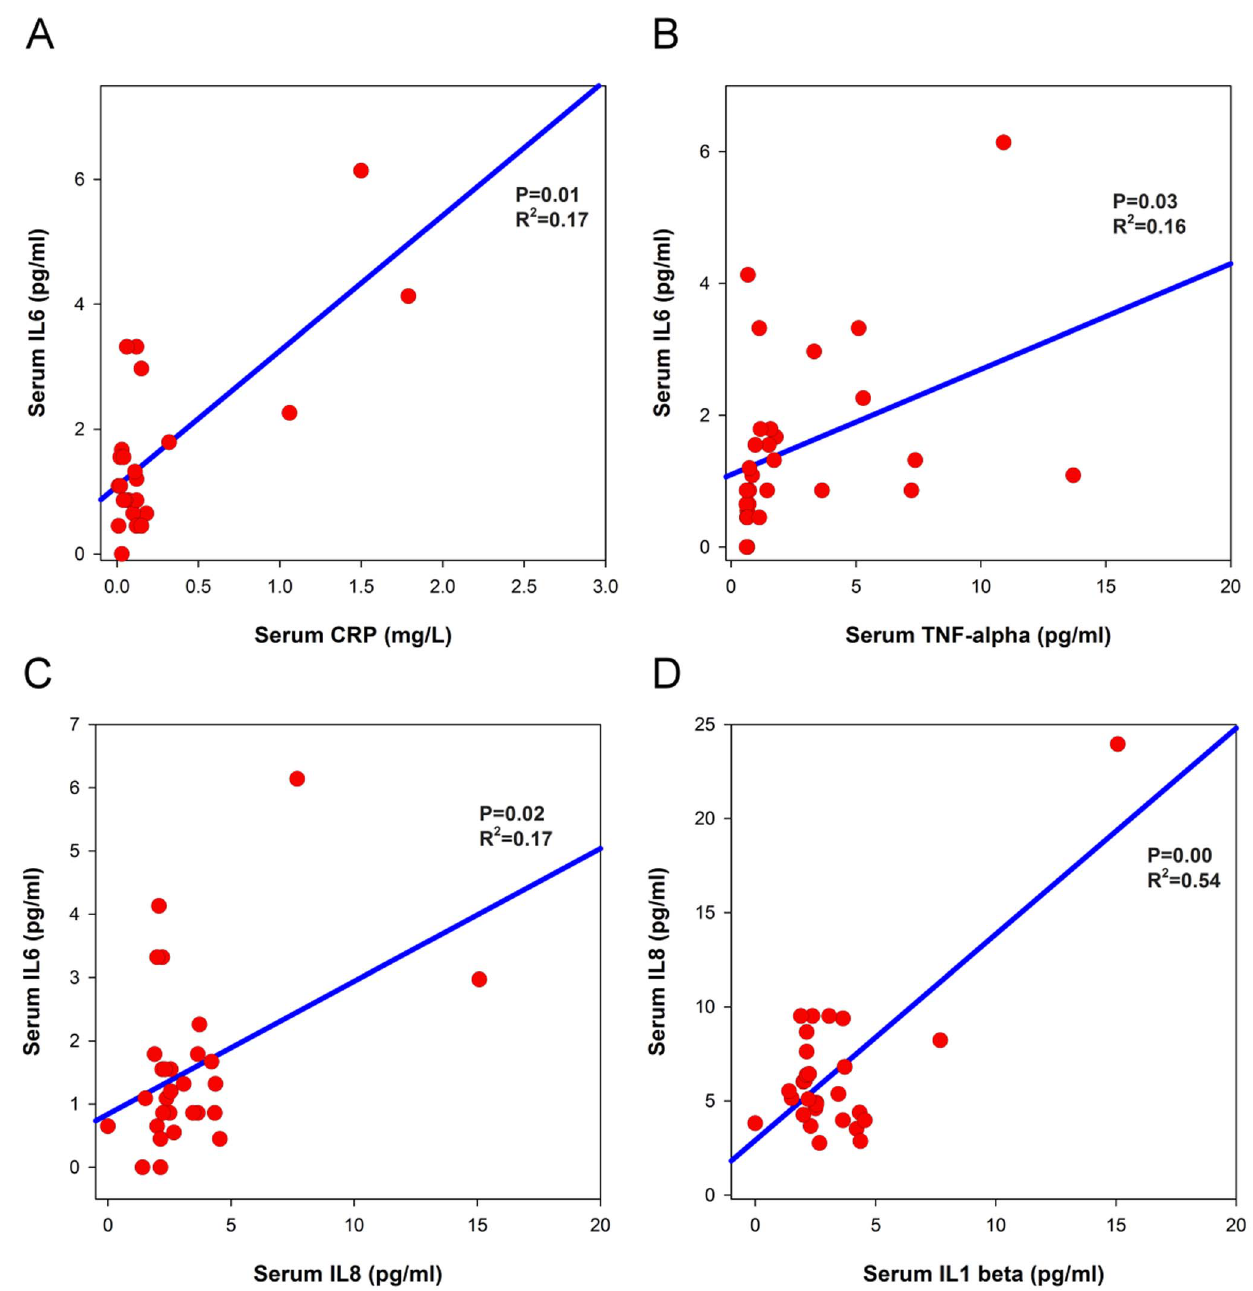
Figure 2. Significant correlations of (A) IL-1 b and CRP, (B) IL-6 and TNF- a , (C) IL-6 and IL-8, and (D) IL-8 and IL-1 b levels in sera of IC/ BPS